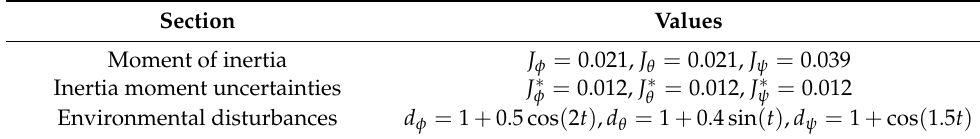
Table 1. Parameters of quadrotor attitude dynamics.